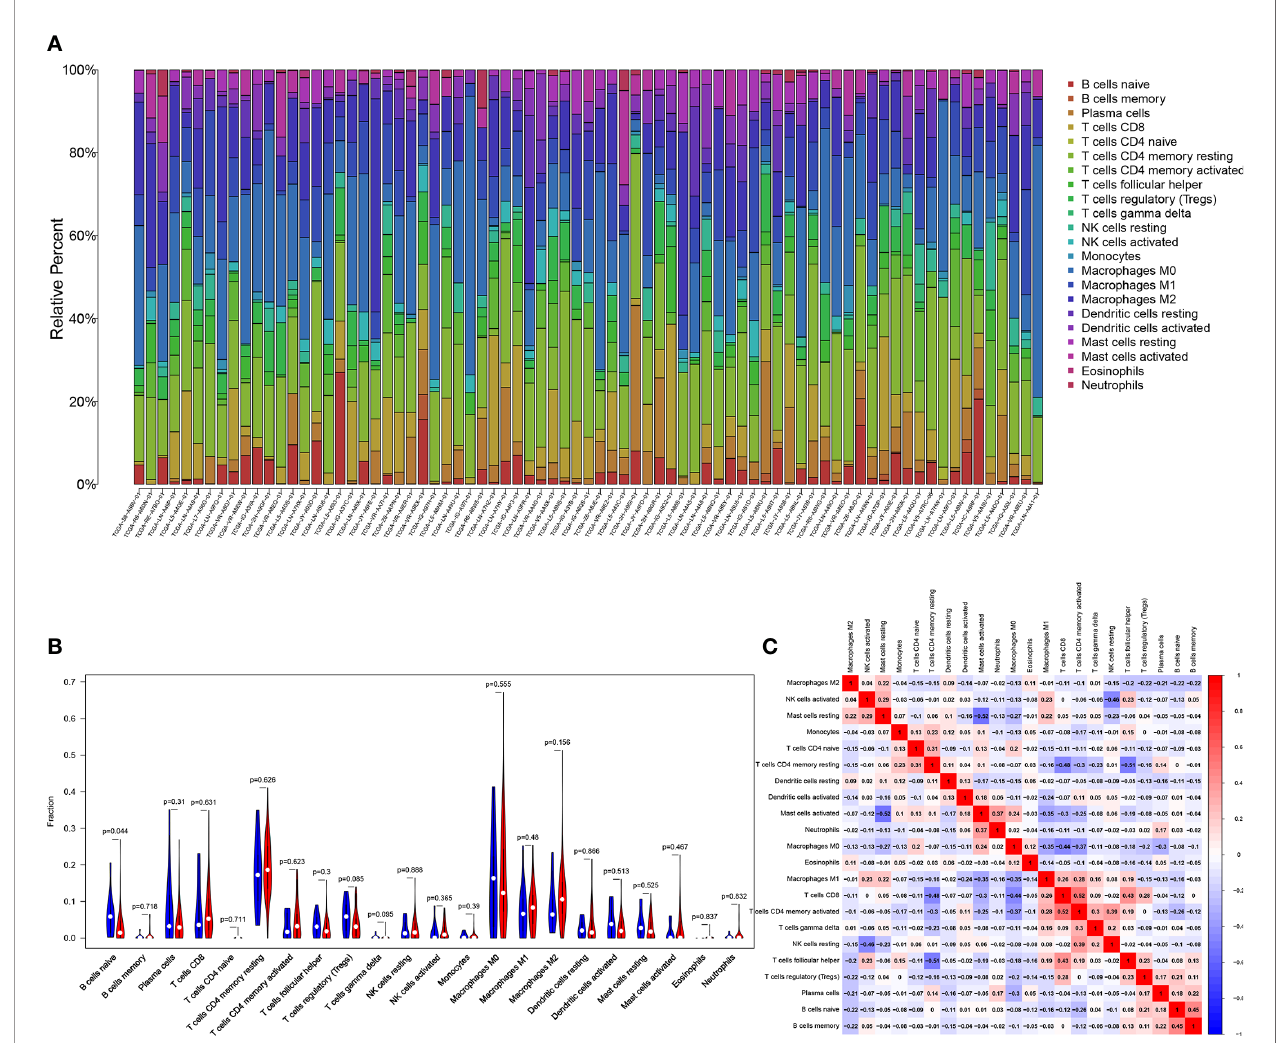
FIGURE 5 | Association of FAT3 mutation with tumor-in fi ltrating Immune. (A) Stacked bar chart shows the proportion of 22 immune cells in each sample of ESCA. (B) Violin plot displays the differentially in fi ltrated immune cells between FAT3-mutant groups and FAT3-wild group. Blue color: FAT3-wild group; Red color: FAT3- mutant group. (C) Correlation matrix of immune cell proportions. Red color: positive correlation; Blue color: negative